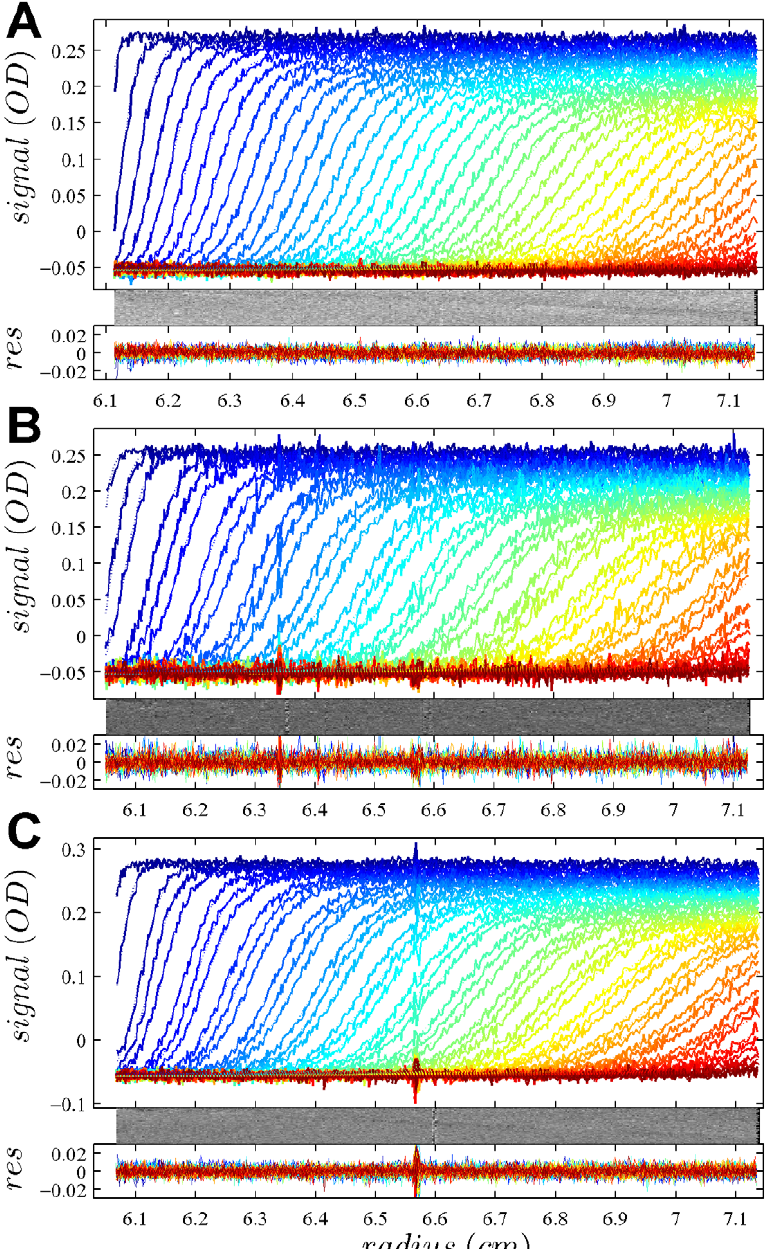
Figure 4. Global density variation SV analysis of the IgG sample recorded with the absorbance data at 280 nm. The sets of panels present the data in (A) H 2 O, (B) 50% H 218 O, and (C) 90% H 218 O based buffer. The presentation is analogous to that in Figure 1. Rmsd of the fit was 0.00462 OD (A), 0.00632 OD (B), and 0.00465 OD (C). The best-fit c ( s ) distribution from this analysis is shown in Figure 5, and the projections of the error surface in Figure